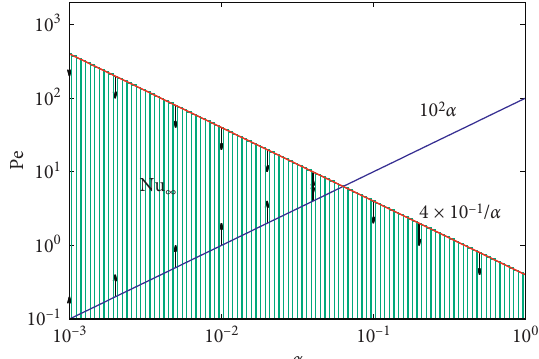
Figure 9: Region of validity of the analytical solution equation (35) (region with vertical bars below the red curve Pe � ( 4 · 10 − 1 / α ) ) and of Nu (triangular region below the red curve ∞ Pe � ( 4 · 10 − 1 / α ) and above the blue curve Pe � 10 2 α